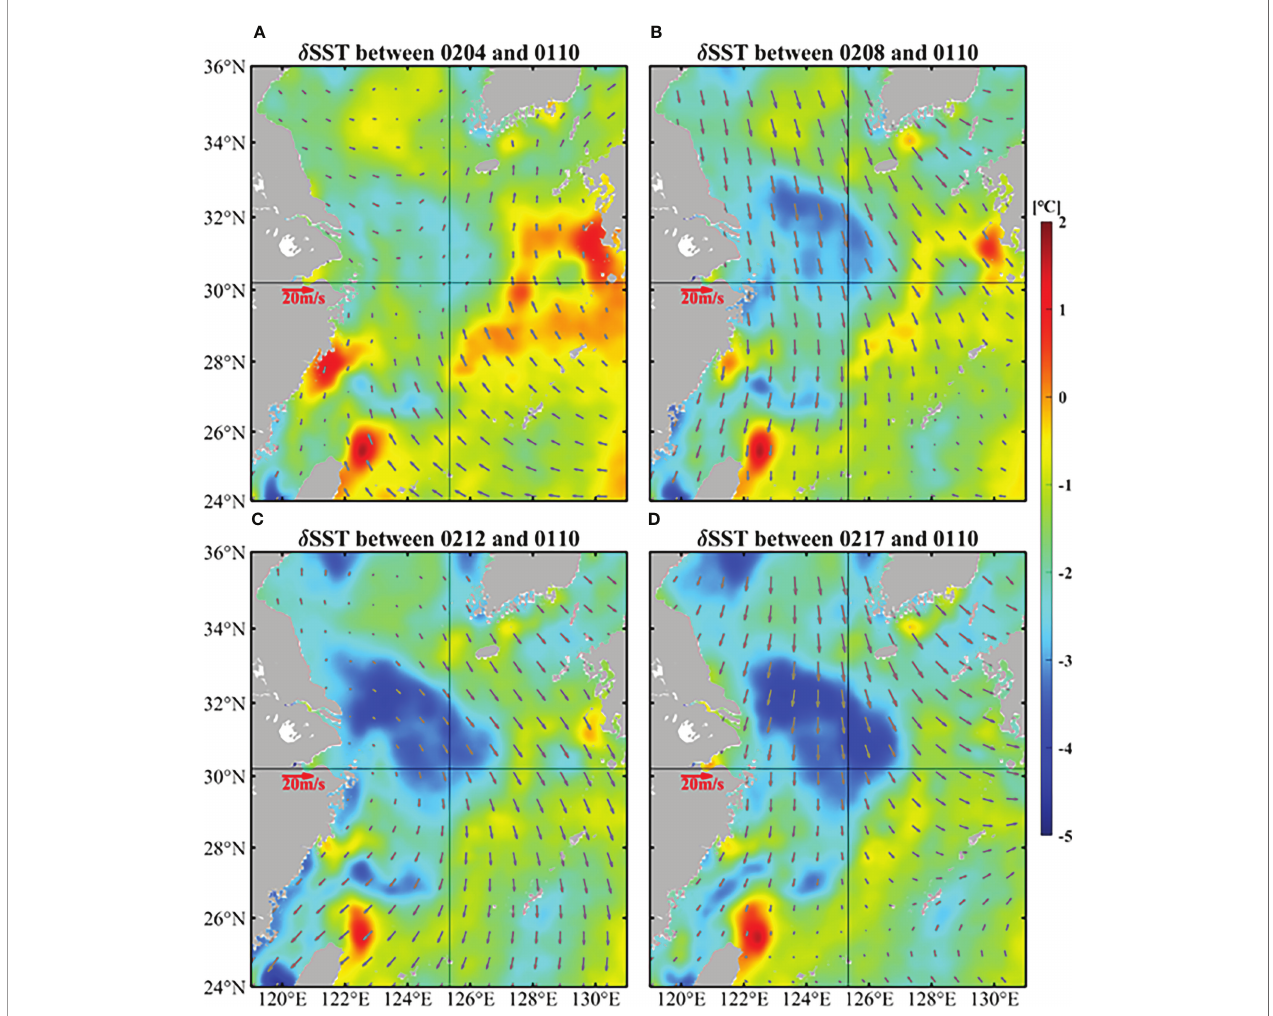
FIGURE 4 | Temperature differences on the basis of 10 January (color shading) and daily average winds (vectors) of 4 (A) , 8 (B) , 12 (C) , and 17 (D) February in the ECS. The SST were obtained from GHRSST and the wind data came from